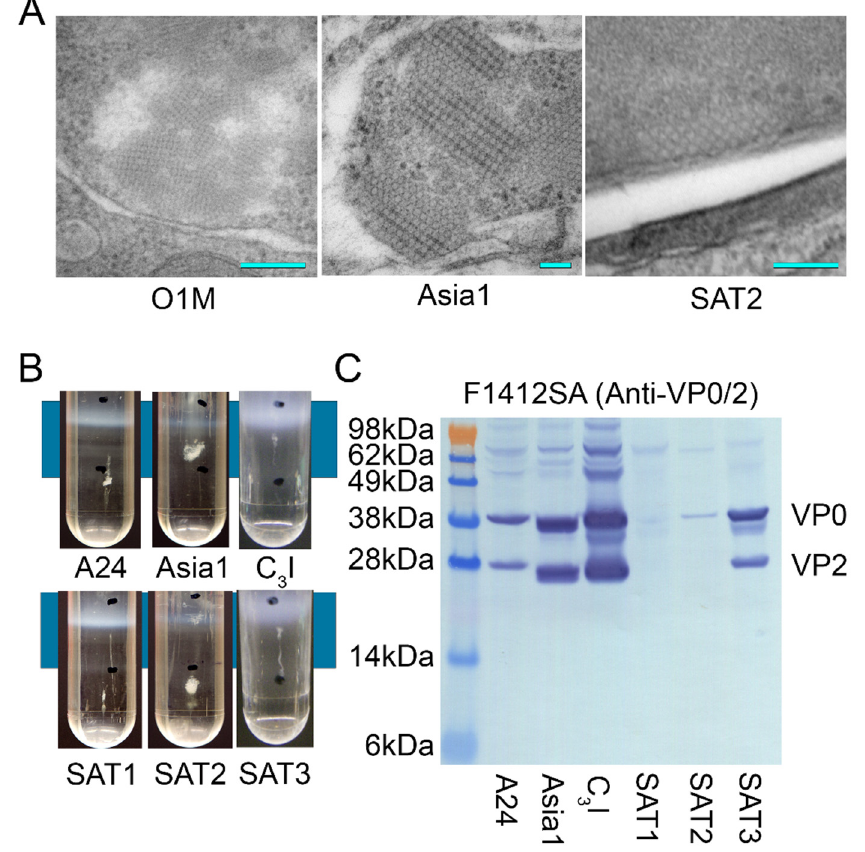
Figure 4. ( A ) Cellular VLP array images captured in cells transfected with constructs expressing FMDV O1M, Asia1, and SAT2 containing constructs. The light blue bar represents 100 nm. ( B ) The visual bands present in the 1.38 g/cm 3 fraction, localized between tube markings, of cesium chloride gradients demonstrated an antigen of the correct size for VLPs in serotypes A24, Asia1, C 3 I, SAT1, SAT2, and SAT3. ( C ) Western blot of the VLP band from cesium chloride gradients utilizing the F1412SA monoclonal antibody, reactive with VP2 and its progenitor VP0, confirmed the presence of both VP2 and VP0 in VLPs.